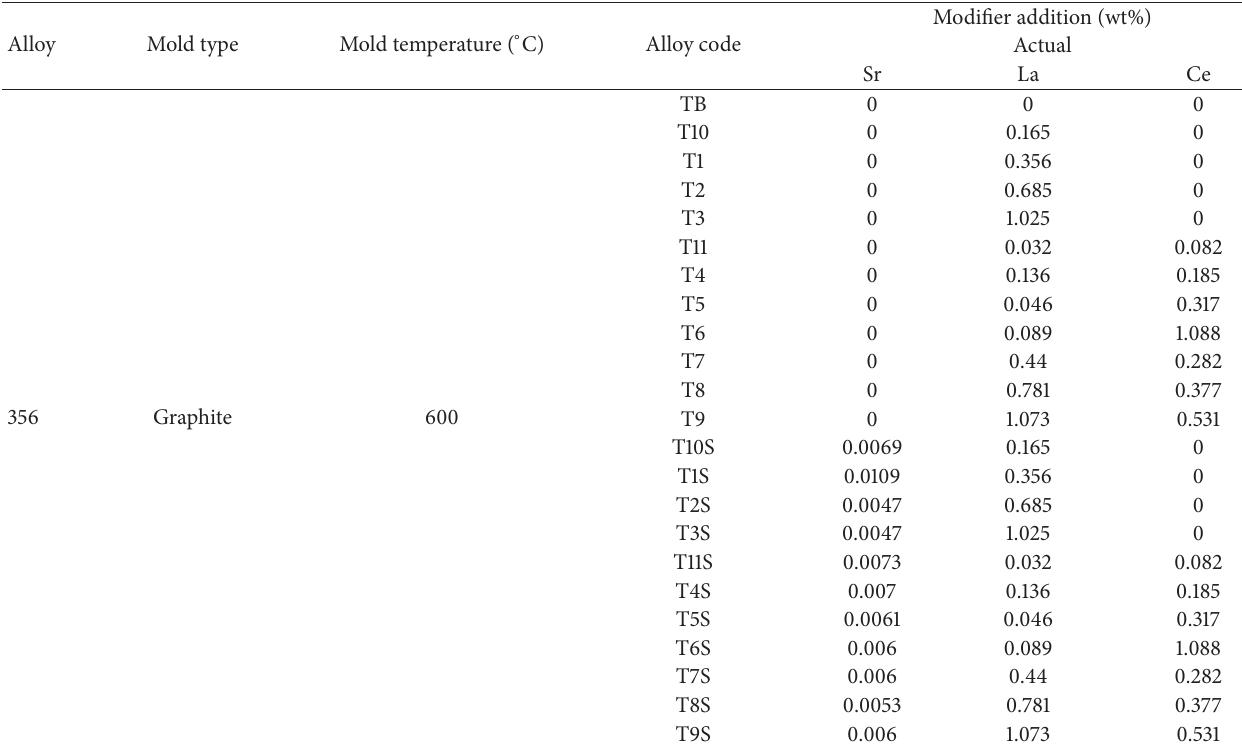
Table 2: Modifier additions and corresponding alloy codes for A3356 alloy.